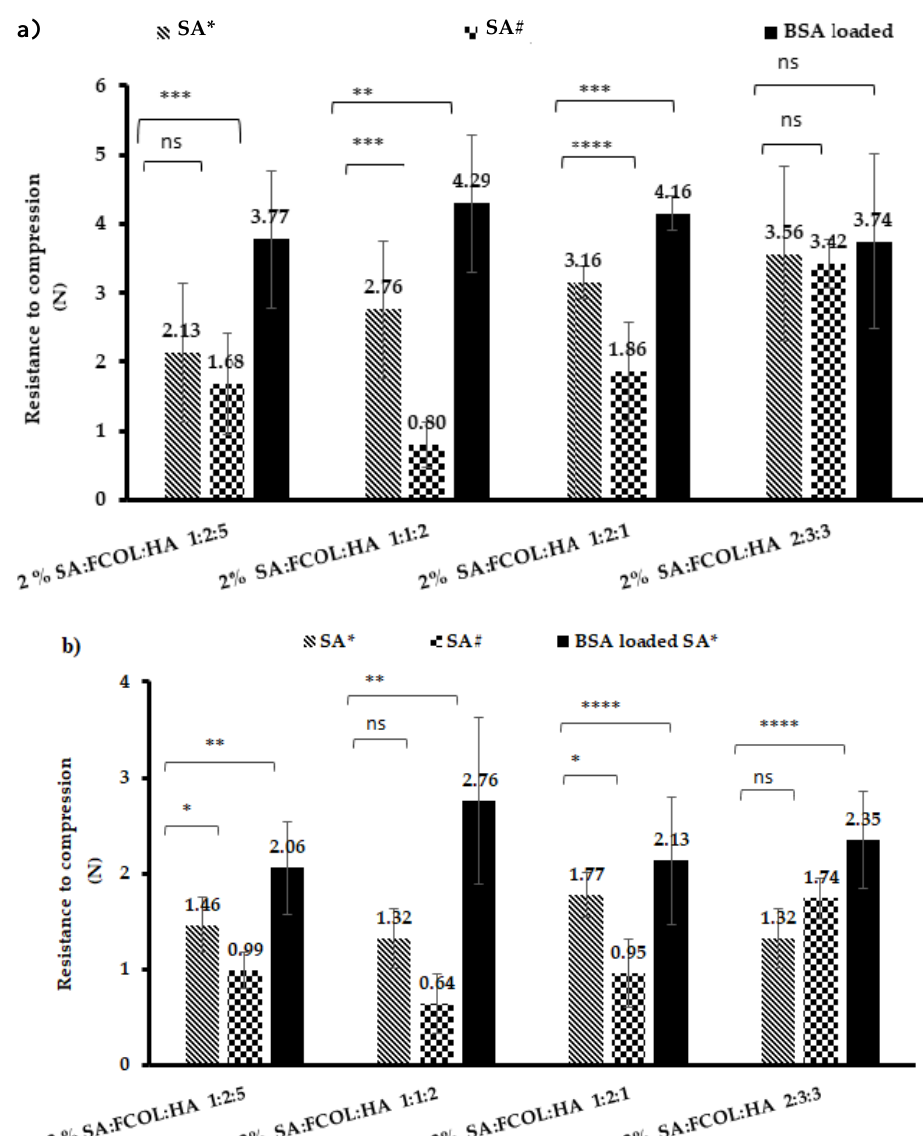
Figure 5. Shows hardness profiles of ( a ) top of the scaffold for composite SA#:FCOL:HA, SA*:FCOL:HA and the optimized BSA loaded formulations ( b ) the bottom of the scaffold for SA#:FCOL:HA, SA*:FCOL:HA and the optimized BSA loaded formulations. Data are shown as mean ± standard deviation (n = 3) . Statistical differences are shown with *, **, *** or **** denoting p < 0.05, p < 0.01, p < 0.001 or p < 0.0001, respectively. Substituting the SA# with Pronatal LF 10/60 (SA*) resulted in significantly ( p < 0.05) higher hardness (Figure 5a,b). Therefore, it is evident that the composition of M, G blocks within the SA has significant effects on the mechanical properties. The values obtained are due to the dominant effect of glycosidic bonds between the blocks that are stiff and do not allow alignment of the alginate molecule under compressive force. As observed in the